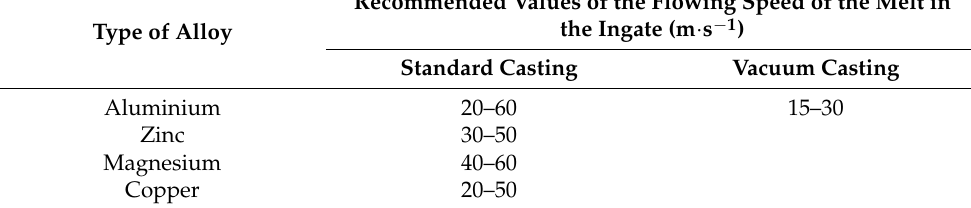
Table 2. Recommended values of the flowing speed of the melt in the ingate.